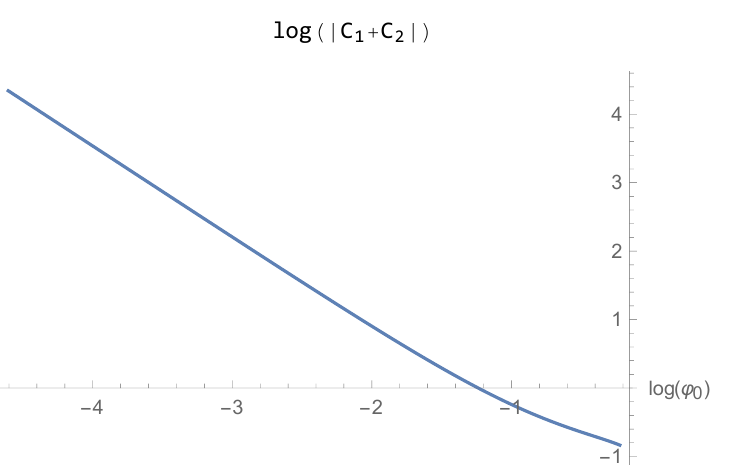
Figure 14 . C 1 ( ’ 0 ) + C 2 ( ’ 0 ) in the case where the sphere 1 shrinks and for T 2 ; 0 = 0. In this situation the space 2 is (cid:13)at ( R 2 =